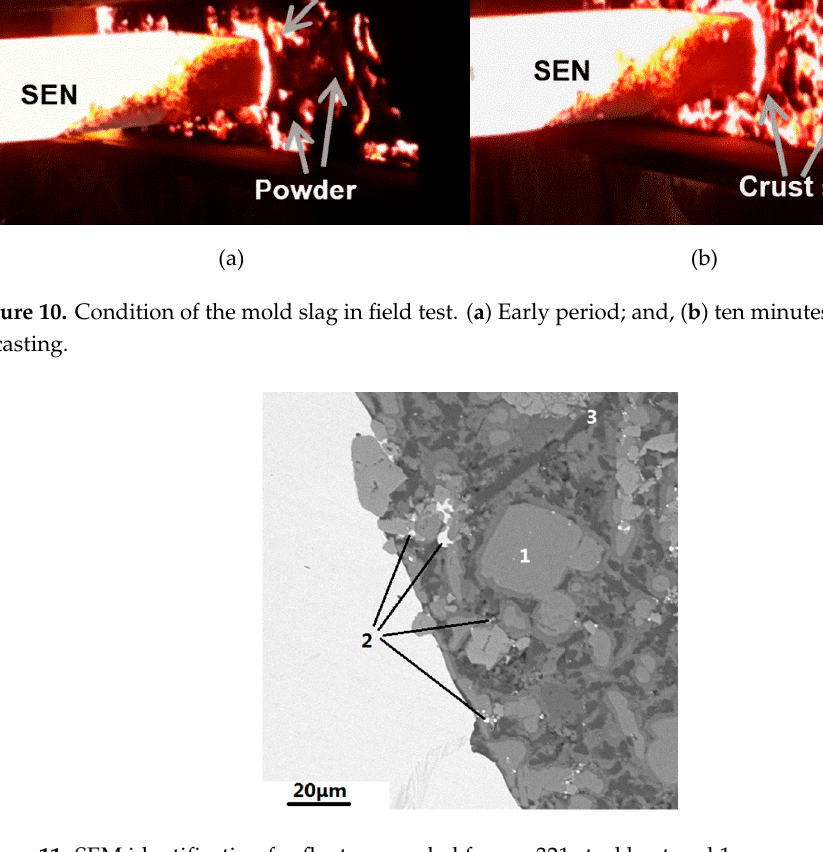
Figure 11. SEM identification for floater sampled from a 321 steel heat and 1 represents CaO·TiO 2 , 2 represents steel phase, and 3 represents Na 2 O·SiO 2 ·Al 2 O 3 .